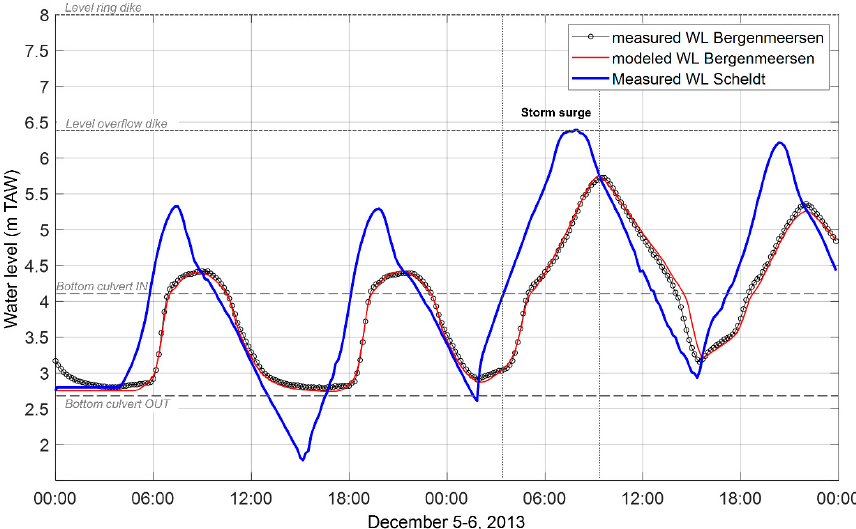
Figure 6. Comparing modeled and measured water level variations inside the FCA with CRT Bergenmeersen for the storm surge on 6 December 2013. Bergenmeersen for the storm surge on 6 December